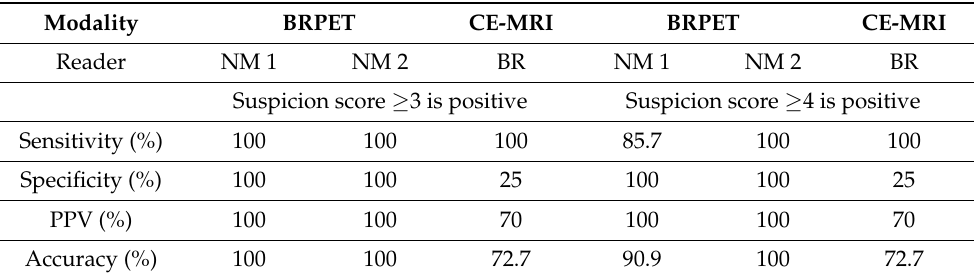
Table 5. Performance metrics for human trial. NM 1 and 2 are nuclear medicine radiologist readers; BR is a breast radiologist reader. PPV = positive predictive value.